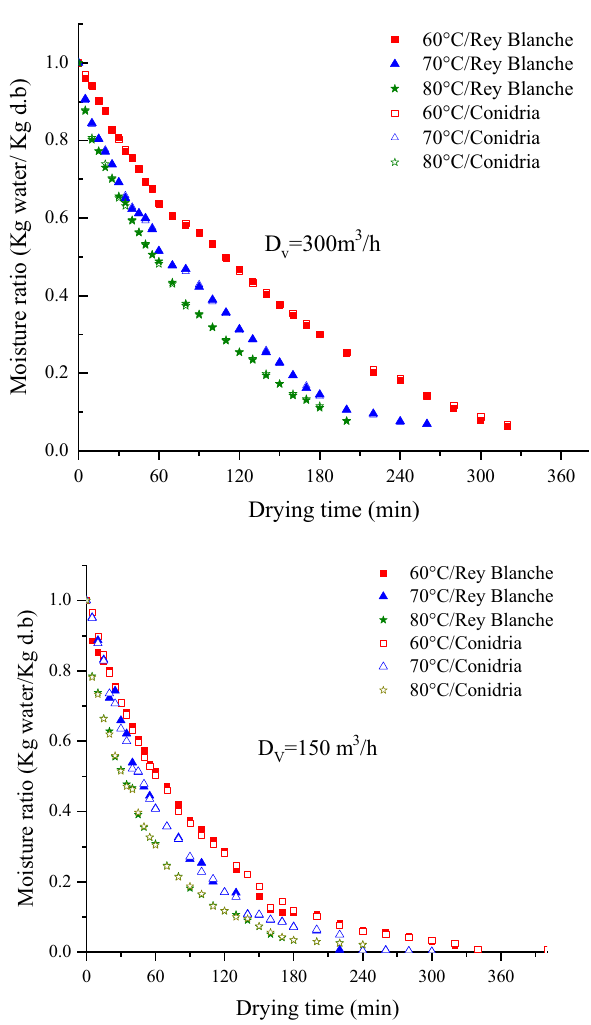
Figure 4. Experimental curves of fig moisture content as a function of time, at various air temperatures (60, 70 and 80 °C) and drying volume flow rate (150 and 300 m 3